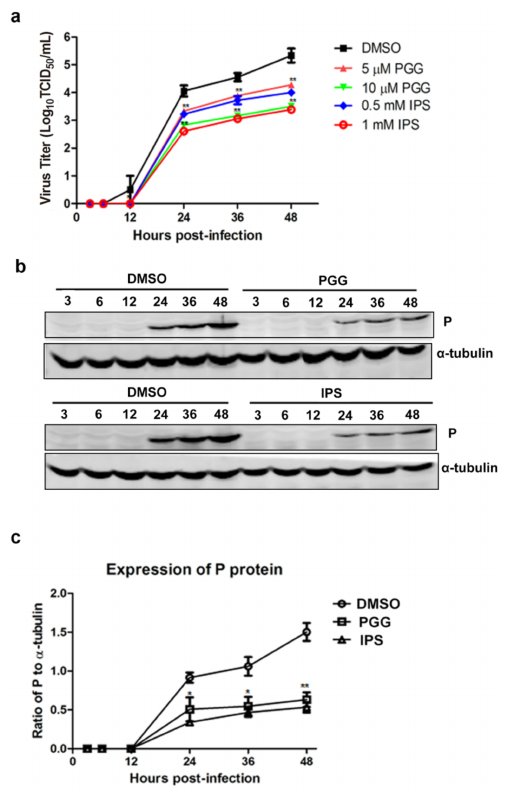
Figure 3. PGG inhibits viral yields and viral protein synthesis. Infected BHK-21 cells were treated with PGG or IPS at various time points. ( a ) Growth kinetics of infected BHK-21 cells during a 48-h period p.i. after treatment with PGG or IPS; ( b ) The viral P protein expression level was analyzed by Western blotting during a 48-h period p.i.; ( c ) The relative expression levels of viral P, normalizing to that of α -tubulin. (* p < 0.05; ** p <